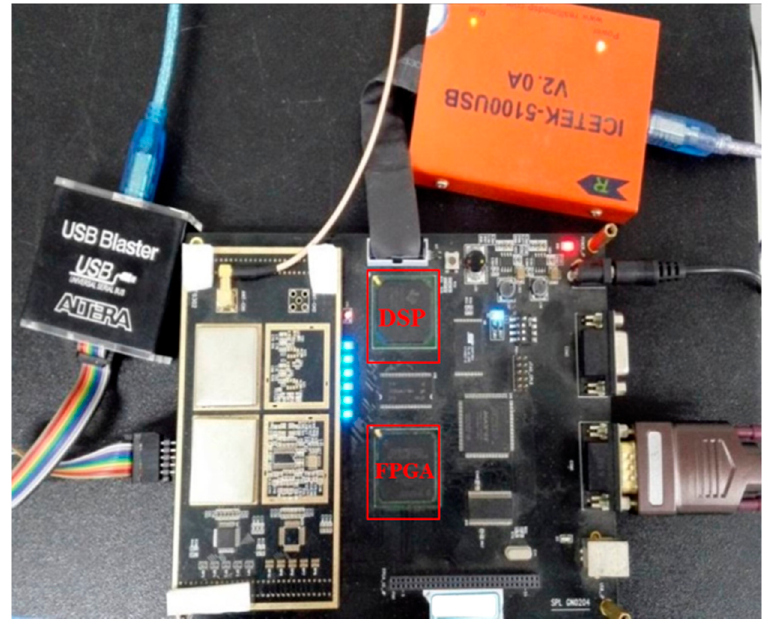
Figure 14. The BeiDou B1I receiver test platform. Table 3. Parameters used in real data tests.